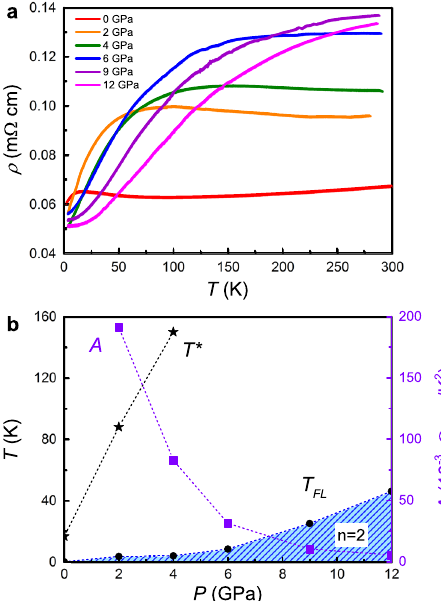
Fig. 3 Pressure dependence of the c -axis resistivity as a function of temperature. a Temperature dependence of the resistivity under pressure. b Temperature-pressure phase diagram derived from the resistivity data, where the coherence temperature, T *, and the Fermi liquid temperature, T FL , are both plotted for comparison. Details on the determination of the Fermi liquid regime ( n = 2) can be found in the Supplementary Fig. S1. Also shown is the pressure dependence of the resistivity coef fi cient, A , de fi ned as ρ − ρ 0 = AT 2 in the Fermi liquid regime